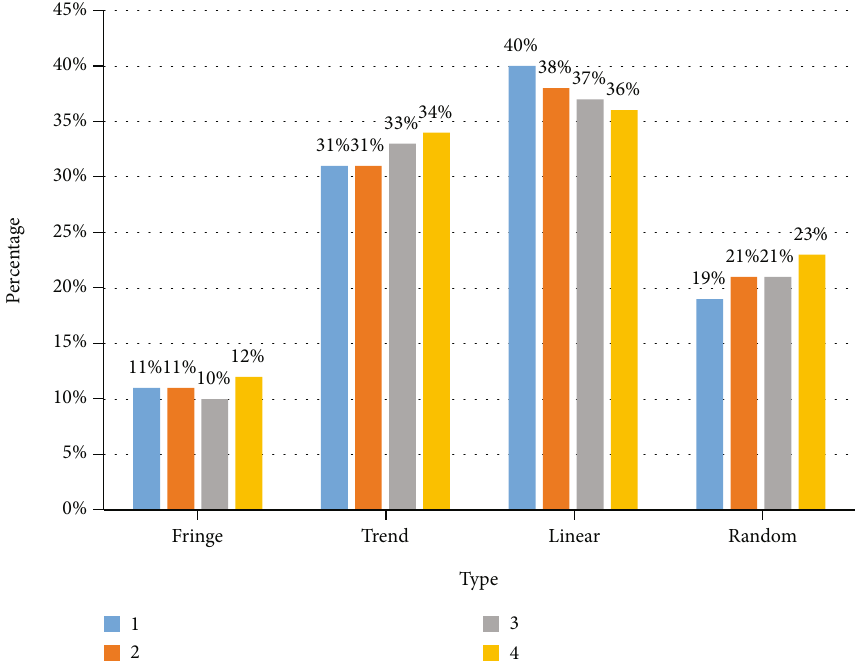
Figure 1: Exercise strategy experiment results. Table 2: New object recognition experiment